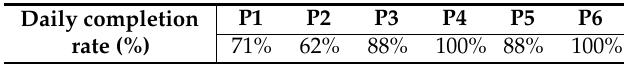
Table 3. The number of days each participant tracked symptoms for